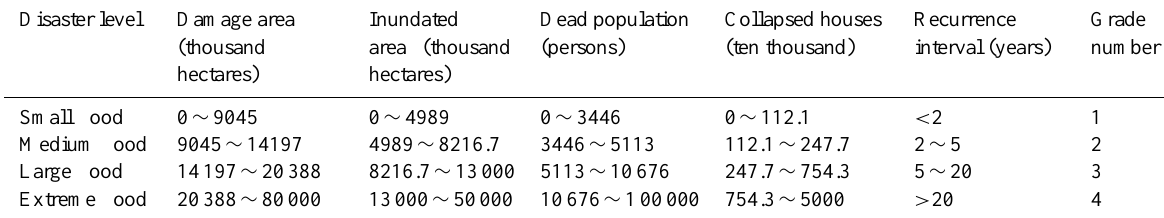
Table 1. Flood disaster rating standard.